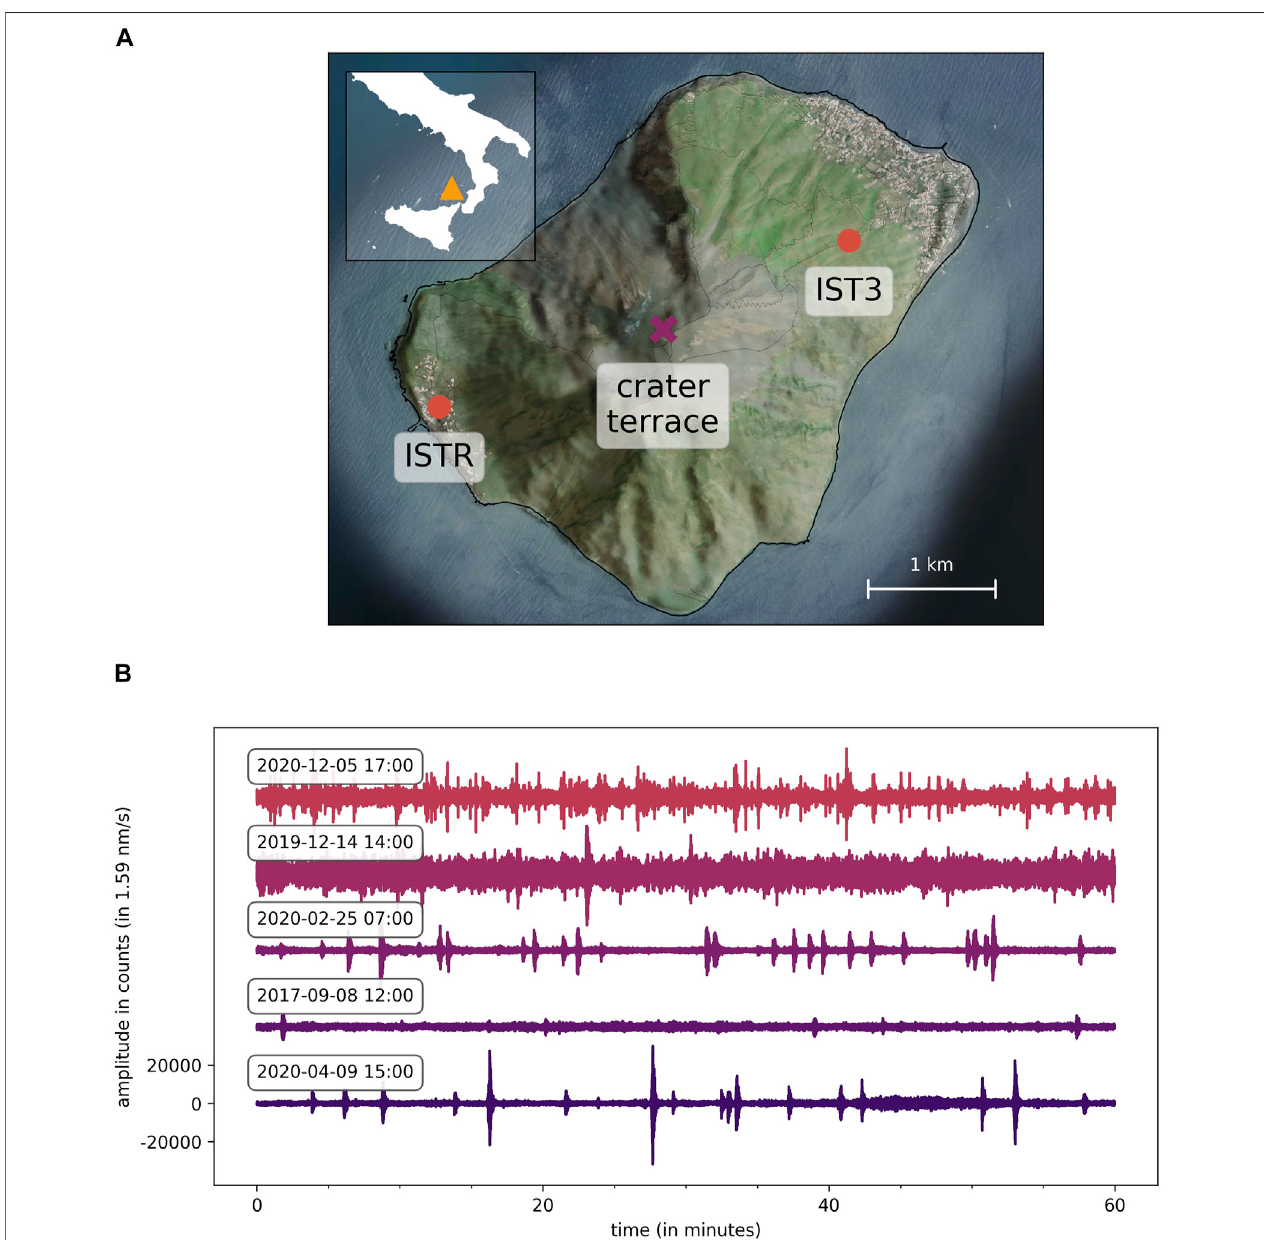
FIGURE 2 | (A) IST3 and ISTR are the two almost equidistant seismic stations on Stromboli used for the detection of volcanic events (topographic data from openstreetmap.org (OpenStreetMap 2017)). (B) Example seismic data with different noise levels and inter-event times recorded at station IST3, channel HHN.